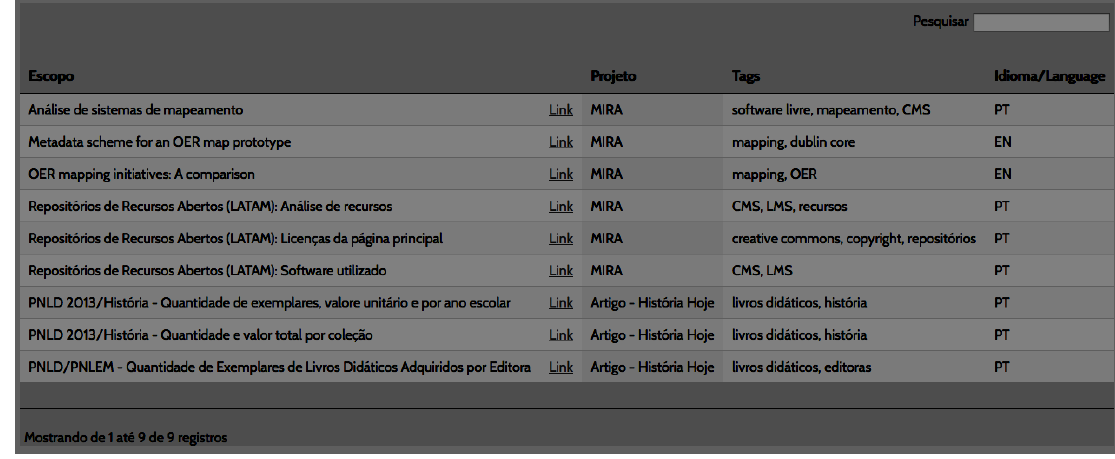
Figure 5. Open data portal with MIRA project